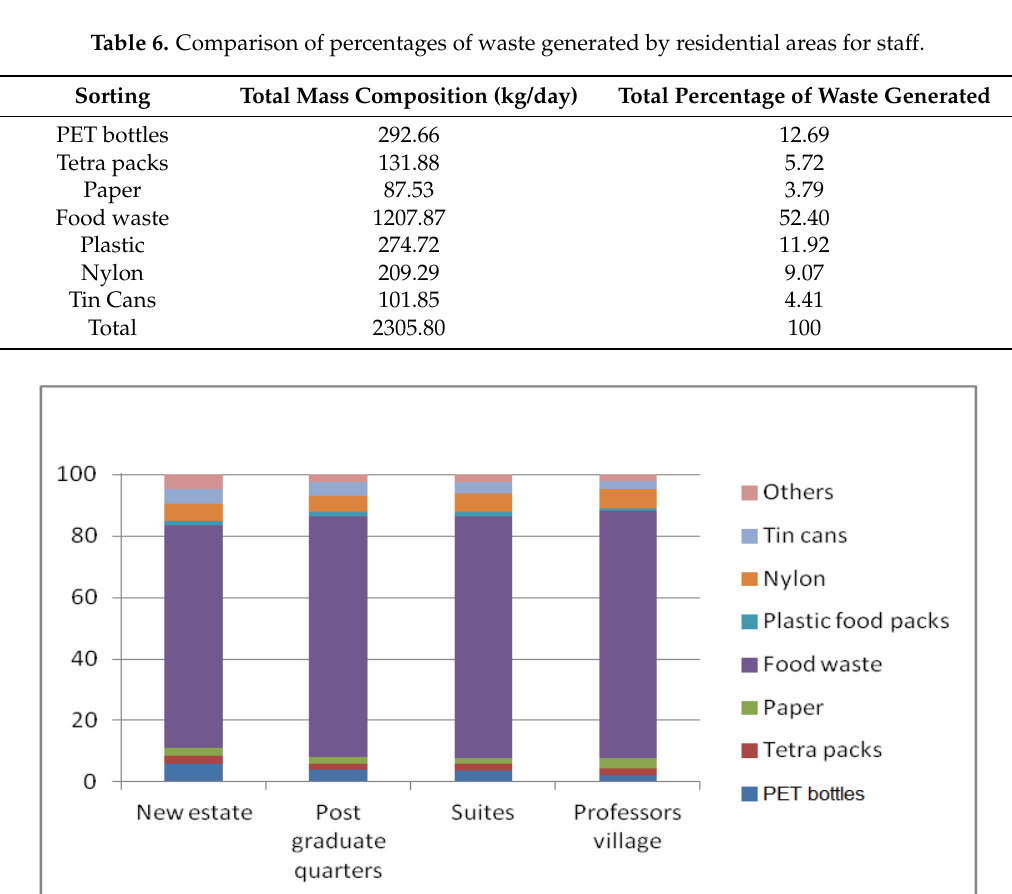
Figure 2. Comparison of percentages of waste generated by residential areas for staff.